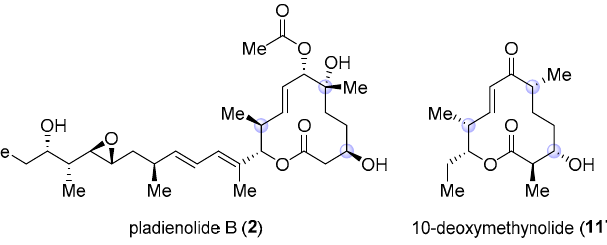
Figure 4. Structural comparison of pladienolide B ( 2 ) and 10-deoxymethynolide ( 117 ).